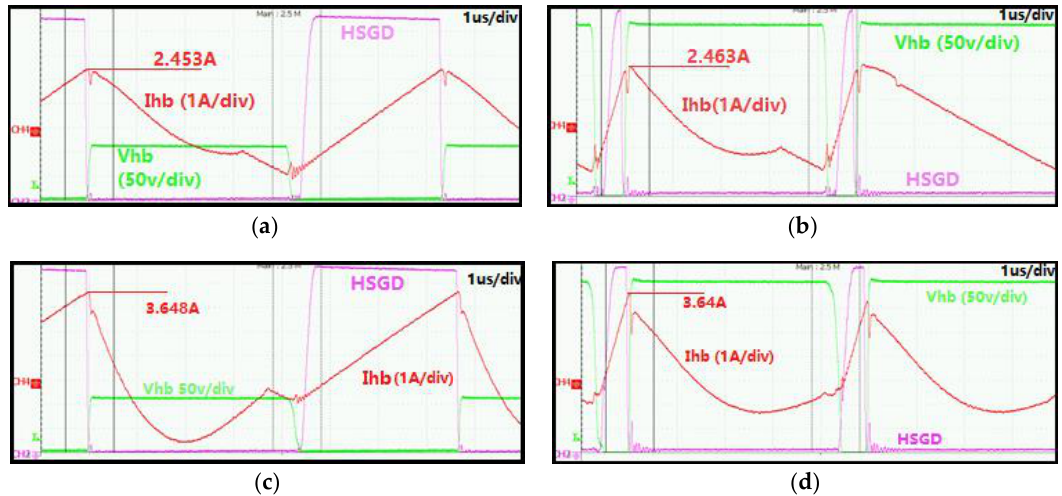
Figure 6. Converter waveforms under different input voltages and load conditions, in this case the turns ratio N is 2.4: ( a ) Vin : 110 Vdc, Iload : 0.6 A; ( b ) Vin : 360 Vdc, Iload : 0.6 A; ( c ) Vin : 110 Vdc, Iload :